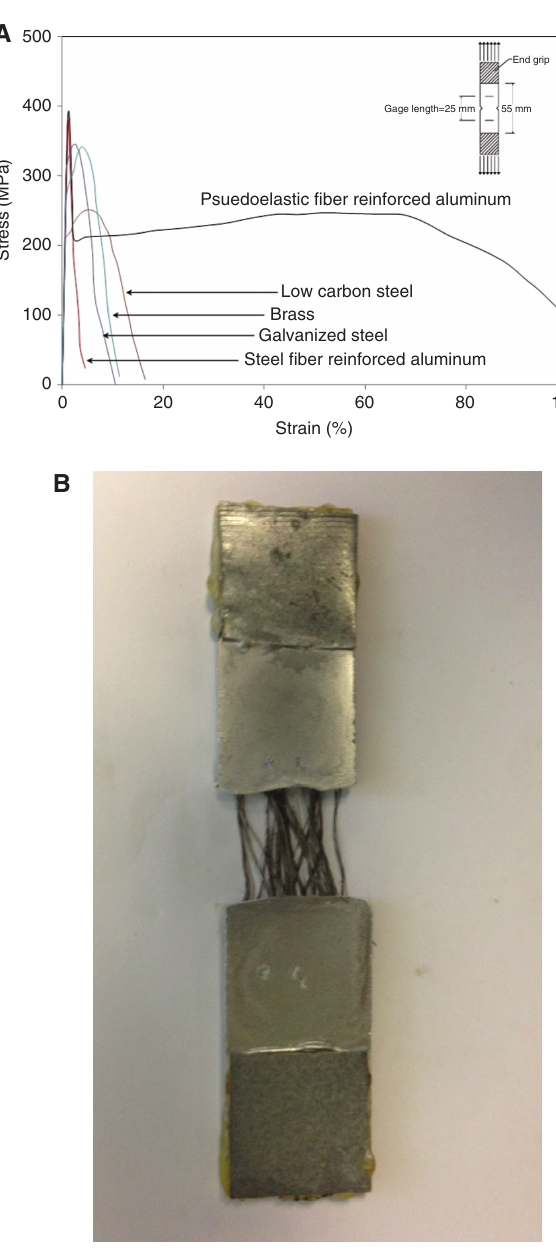
Figure 6 Comparative tensile stress-strain behavior of notched specimens. (A) Tensile stress-strain Curves. (B) Picture of failed specimen with pseudoelastic fibers.